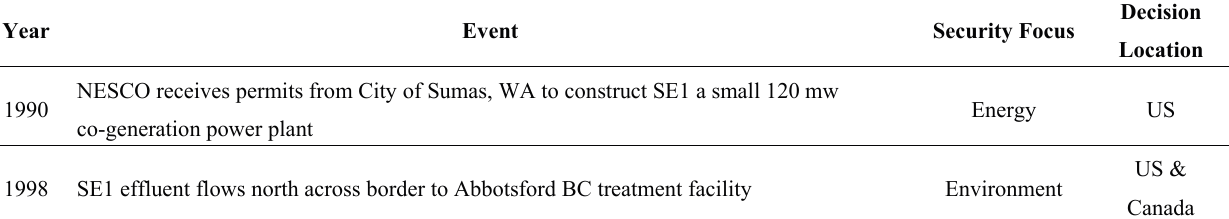
Table 3. Power plant events timeline, security focus, and decision